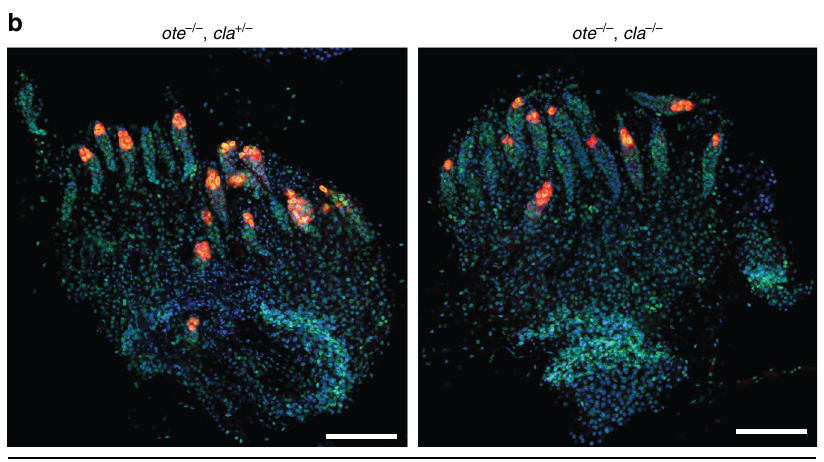
Fig. 4 DNA damage in ote − / − GSCs is downstream of Chk2. a Confocal images of germaria stained with antibodies against Vasa (red), DNA damage marker γ -H2Av (grayscale) and with DAPI (blue). Genotypes are noted above each image, wherein ote − / − corresponds to ote B279G/PK and chk2 − / − corresponding to chk2 P6/P30 . Bottom: Image of the signal in the γ -H2Av channel. Boxes and brackets indicate GSCs and meiotic germ cells, respectively. Dashed line indicates the position of GSC niche. The percentage of γ -H2Av-positive GSCs is noted at the bottom of the γ -H2Av image, with the number of GSCs analyzed in parenthesis. All scale bars represent 20 µ m. b Confocal images of whole mount ovaries dissected from ote mutants with heterozygous or homozygous loss of Claspin (Cla). Ovaries were stained for Vasa (red), Lamin Dm0 (green), and DNA (DAPI, blue), revealing the absence of suppression of ote mutant phenotypes. Genotypes are indicated at the top of each image, with ote − / − corresponding to ote B279G/PK ; scale bars represent 100 µ